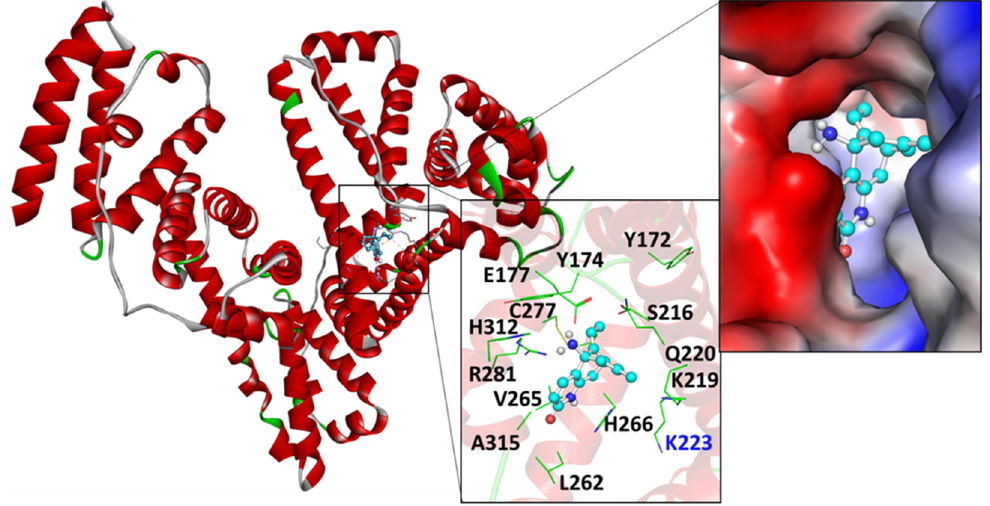
Figure 1. The binding of HpzA with HSA. Ribbon and surface representation of HSA protein showing various interactions and docking fit of HpzA (UniProt ID: P02768).